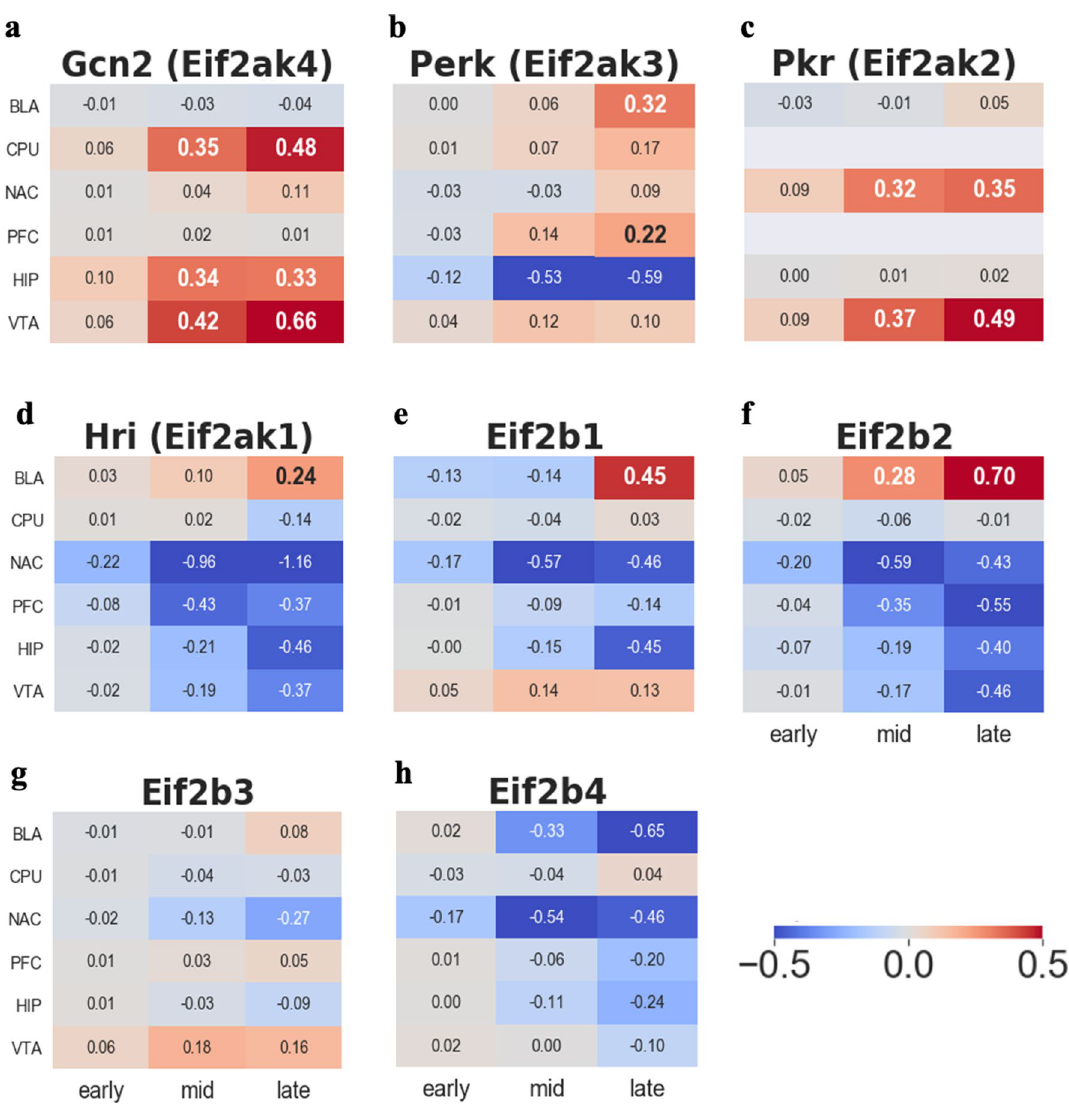
Figure 3. Log2FC trend for general translation inhibition related genes. ( a ) General control nonderepressible 2 ( Gcn2 ) ( b ) PKR-like endoplasmic reticulum kinase ( Perk ) ( c ) protein kinase R ( Pkr ) ( d ) heme-regulated inhibitor kinase ( Hri ) ( e ) Translation initiation factor eIF-2B subunit alpha ( Eif2b1 ) ( f ) Translation initiation factor eIF-2B subunit beta ( Eif2b2 ) ( g ) Translation initiation factor eIF-2B subunit gamma ( Eif2b3 ) ( h ) Translation initiation factor eIF-2B subunit delta ( Eif2b4